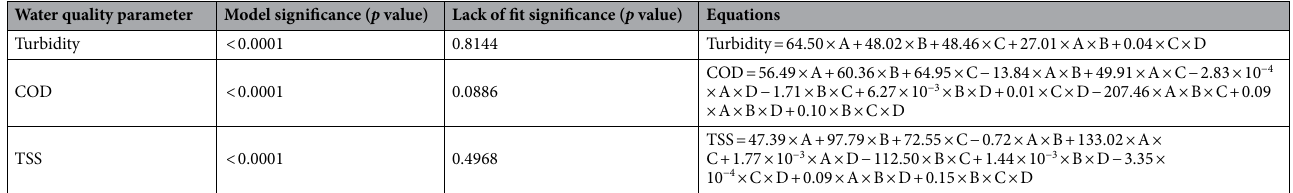
Table 4. ANOVA results and final equations in terms of components and factor by response type. A: Biocoagulant, B: Aluminum sulfate, C: Ferric sulfate, D: Doses.